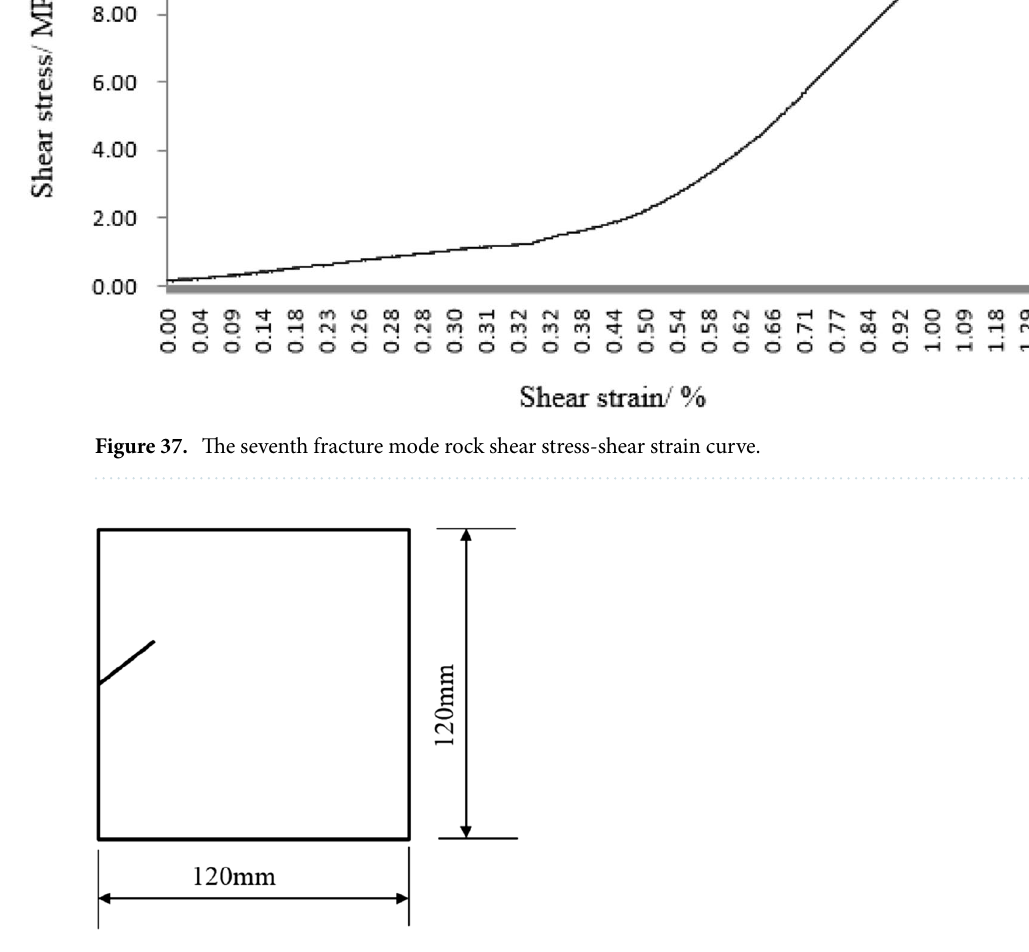
Figure 38. Fissure length 2 cm, horizontal angle of fissure 40°, in specimens with different grain size